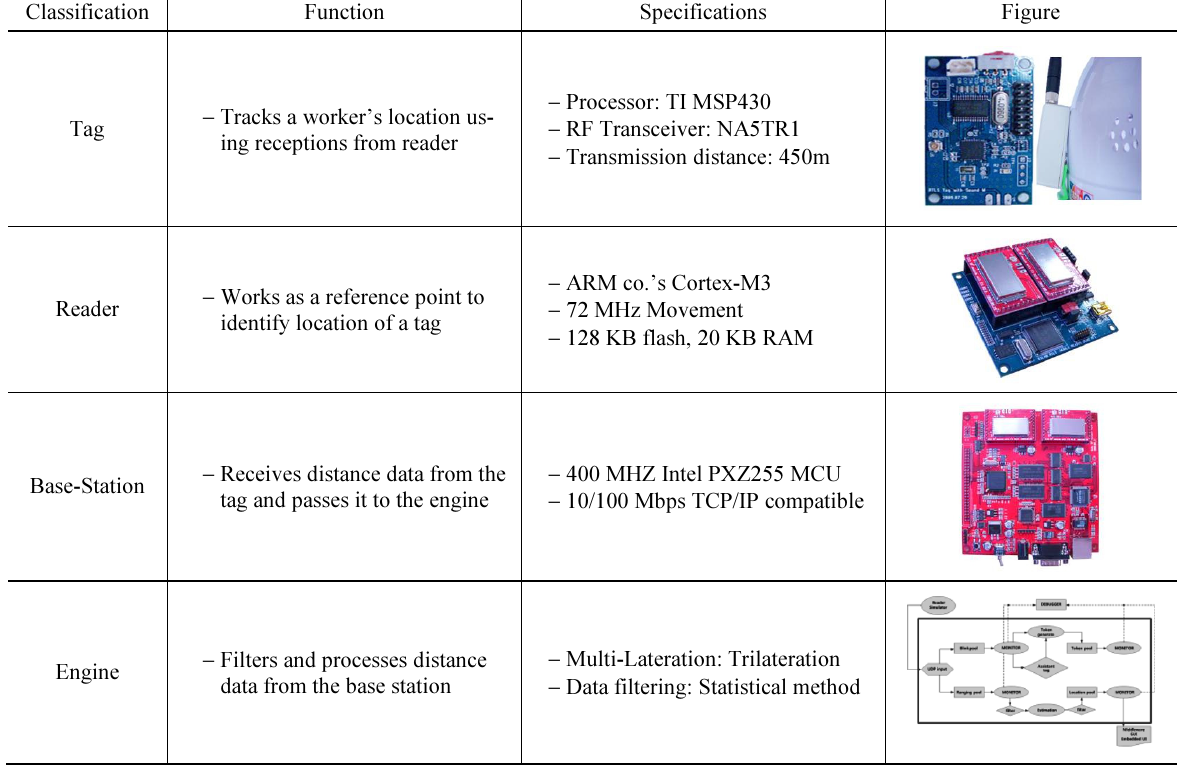
Table 2. RTLS hardware Classification Function Specifications